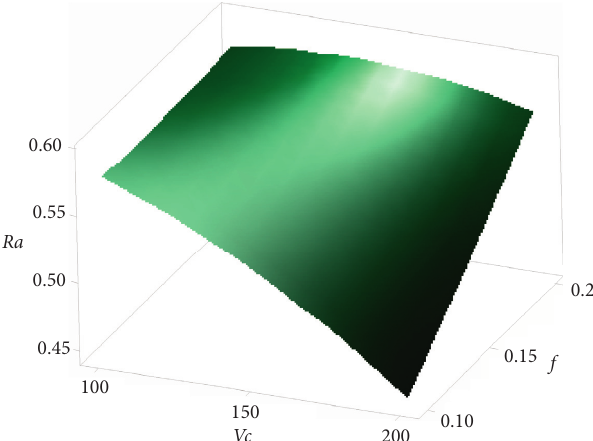
Figure 5: Predicted RSM values for surface roughness on Vc and f